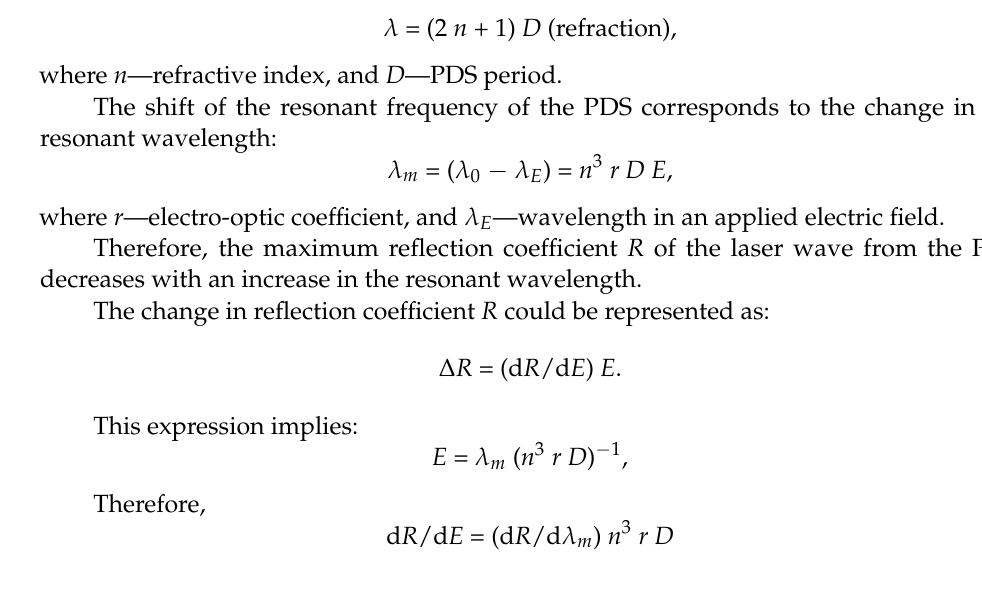
Figure 8. Single PD signal received by the EM channel of the portable device.